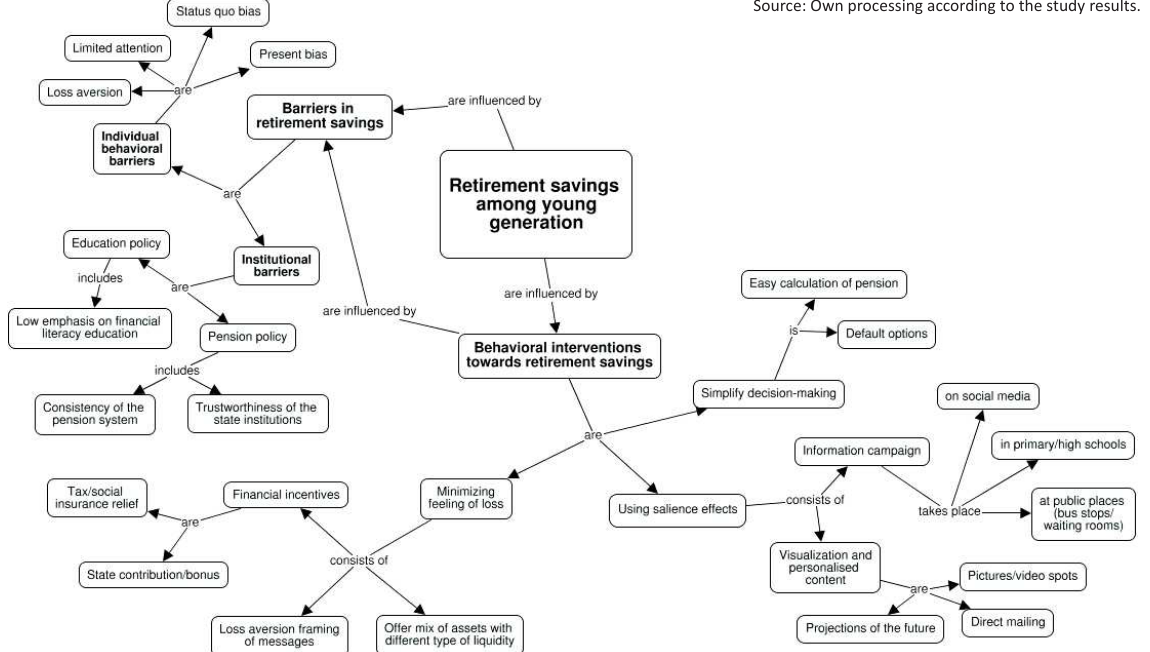
Figure 1. Conceptual map introducing results from online focus